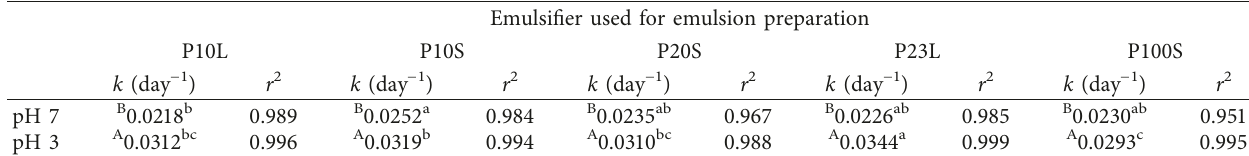
Figure 5: Change in concentration of α -tocopherol in emulsions in the presence of radicals at pH 7 (a) and 3 (b) stored at 25 ° C. P10L, polyoxyethylene 10 lauryl ether; P10S, polyoxyethylene 10 stearyl ether; P20S, polyoxyethylene 20 stearyl ether; P23L, polyoxyethylene 23 lauryl ether; P100S, polyoxyethylene 100 stearyl ether. Table 2: The decomposition rate ( k ) of α -tocopherol in emulsions stabilized with emulsifiers having various sizes of hydrophilic and hydrophobic groups in presence of